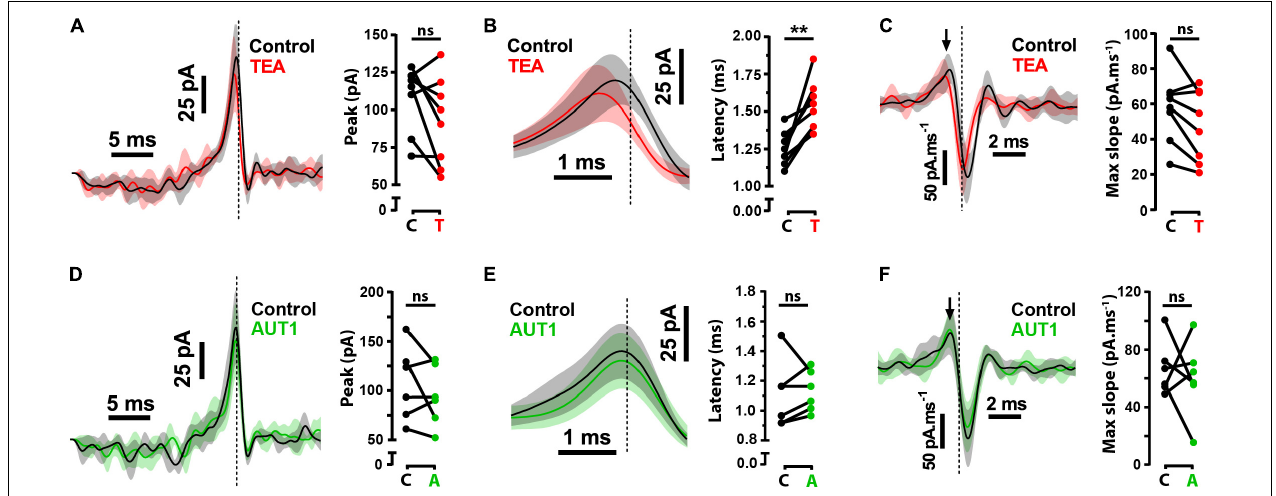
FIGURE 3 | Effects of Kv3 K + current modulation on the spike-triggered average (STA). (A,D) Left: Whole-cell current clamp recordings showing the average STA in the control condition (black) and following perfusion of TEA ( A , red) or AUT1 ( D , green). Right: Neither TEA (A) nor AUT1 (D) affected the peak STA. (B,E) Left: The STA depicted on an expanded time scale showing the latency between the STA peak and the time of action potential occurrence in control (black) and following TEA (B) or AUT1 perfusion (E) . Right: Perfusion of TEA (B) or AUT1 (E) increased or failed to affect the latency between the STA peak and the time of action potential occurrence respectively. (C,F) Left: The first derivative of the STA quantifying the peak (maximum) slope of the STA (black arrow), in the control and TEA conditions (C) and the control and AUT1 conditions (F) . Right: data plot showing the absence of effect of TEA (C) and AUT1 (F) . (A–F) Vertical dashed lines in STA plots indicate the time of action potential occurrence. Shaded error bars = SD. (A,B,D,E) STAs have been low pass filtered at 500 Hz for visualization. Peak and latency values are obtained from unfiltered STAs. (A–C) : n = 8; (D–F) n = 6. ** p <